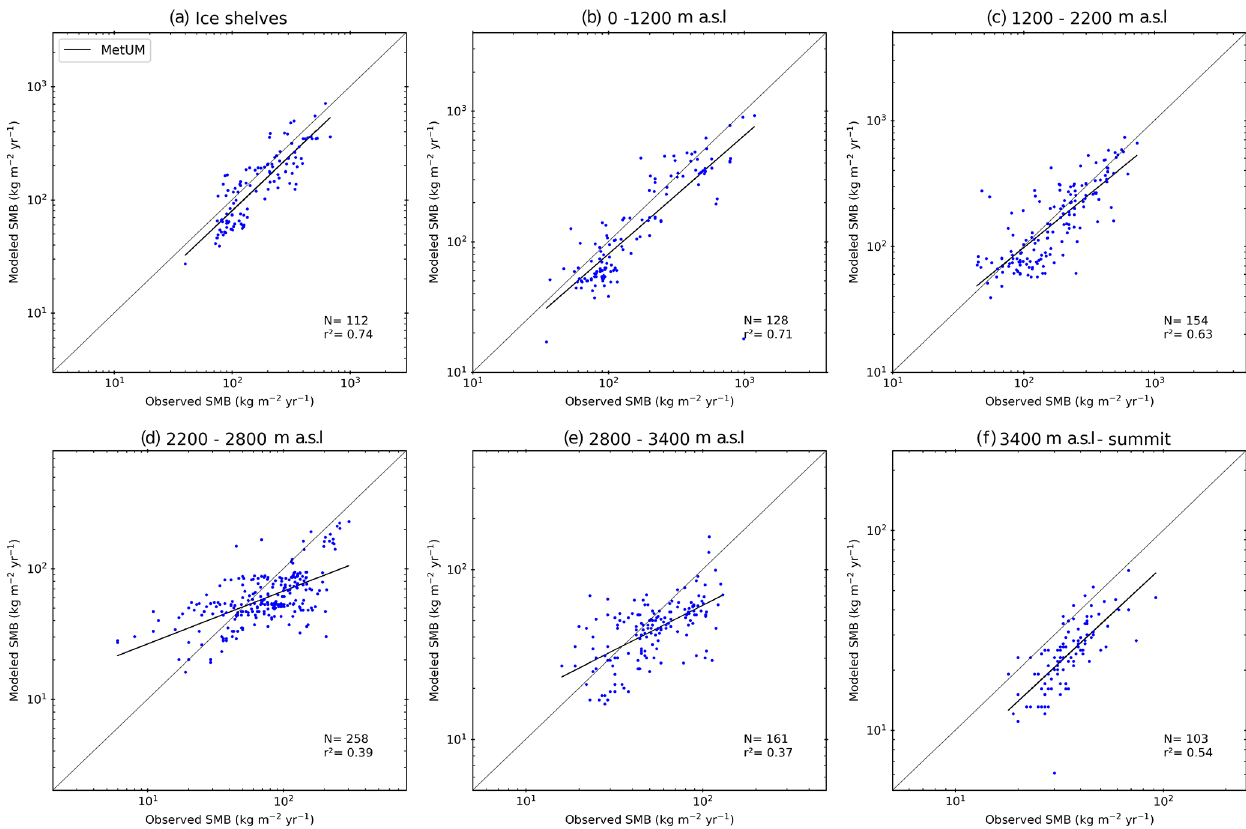
Figure A7. Comparison between MetUM and observed SMB (units: kgm − 2 yr − 1 ) over the ice shelves (a) and by elevation classes (b–f) . Due to the use of logarithmic axes, only positive values for the observed and modelled SMB from all the RCMs in this study are used (number for each bin N ). Finally, the regression coefficient of each regression line is also shown ( r 2